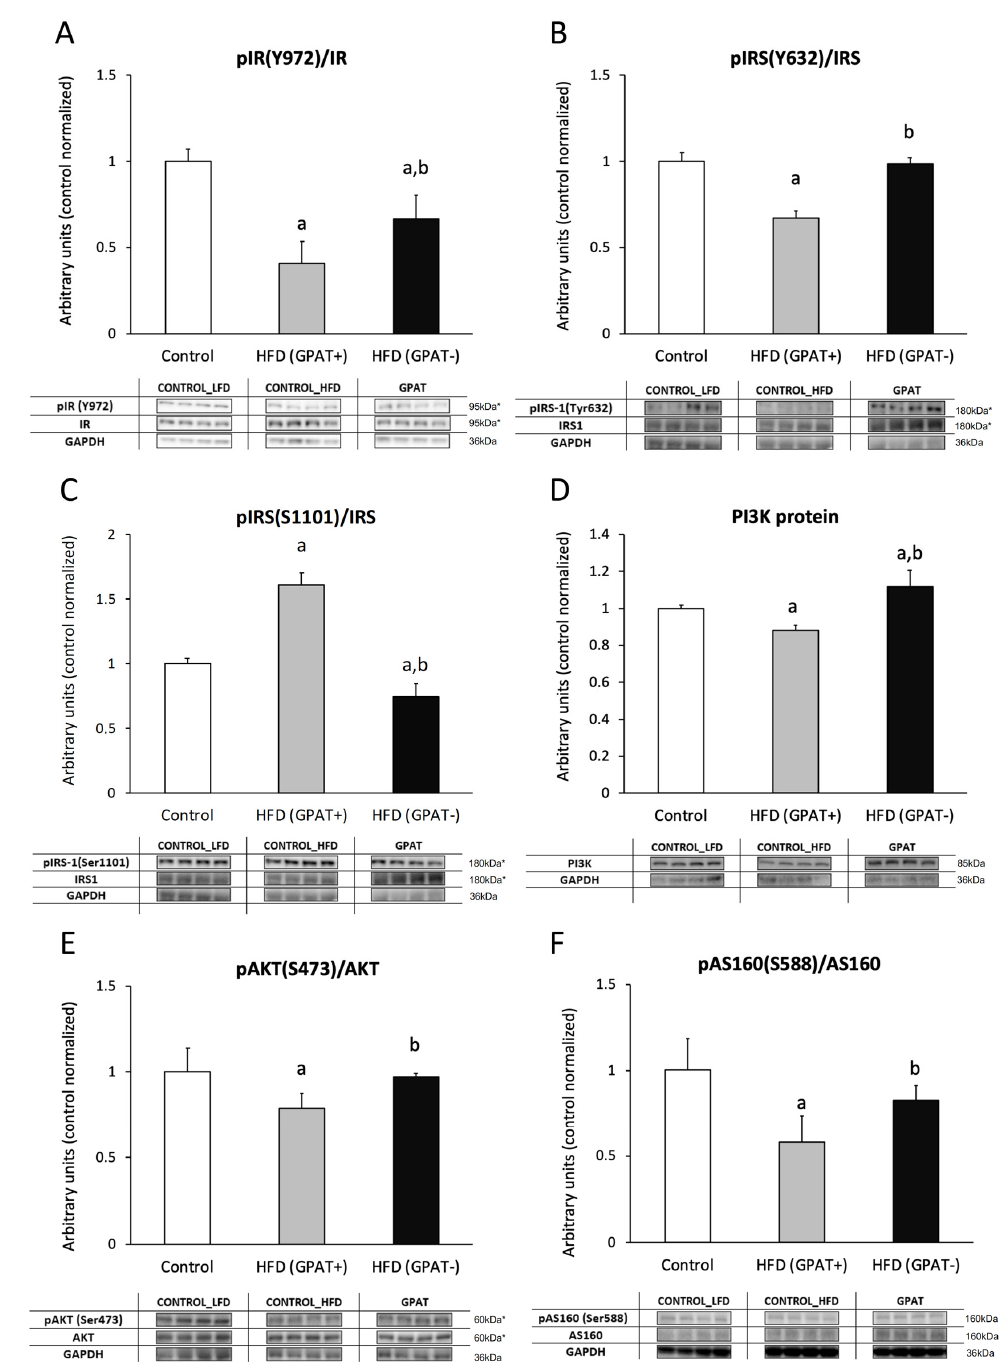
Figure 4. Activation of insulin signaling pathways in GPAT-silenced mouse gastrocnemious muscle. Panel A —insulin receptor phosphorylation (pIR Y972); Panel B —insulin receptor substrate 1 (IRS1) tyrosine phosphorylation (pIRS1 Y632); Panel C —IRS1 serine phosphorylation (pIRS S1101). Panel D —protein expression of phosphoinositide 3-kinase (PI3K); Panel E —serine phosphorylation of protein kinase B / Akt (pAKT S473); Panel F —serine phosphorylation of Akt / PKB 160kDa substrate (pAS160 S588). Values are mean ± SD ( n = 8); a— p < 0.05 vs. control; b— p < 0.05 vs. HFD (GPAT + ) : statistics by ANOVA; HFD—high-fat diet. * The observed molecular weight of indicated proteins is different to the theoretical one, as stated by the antibody manufacturer.